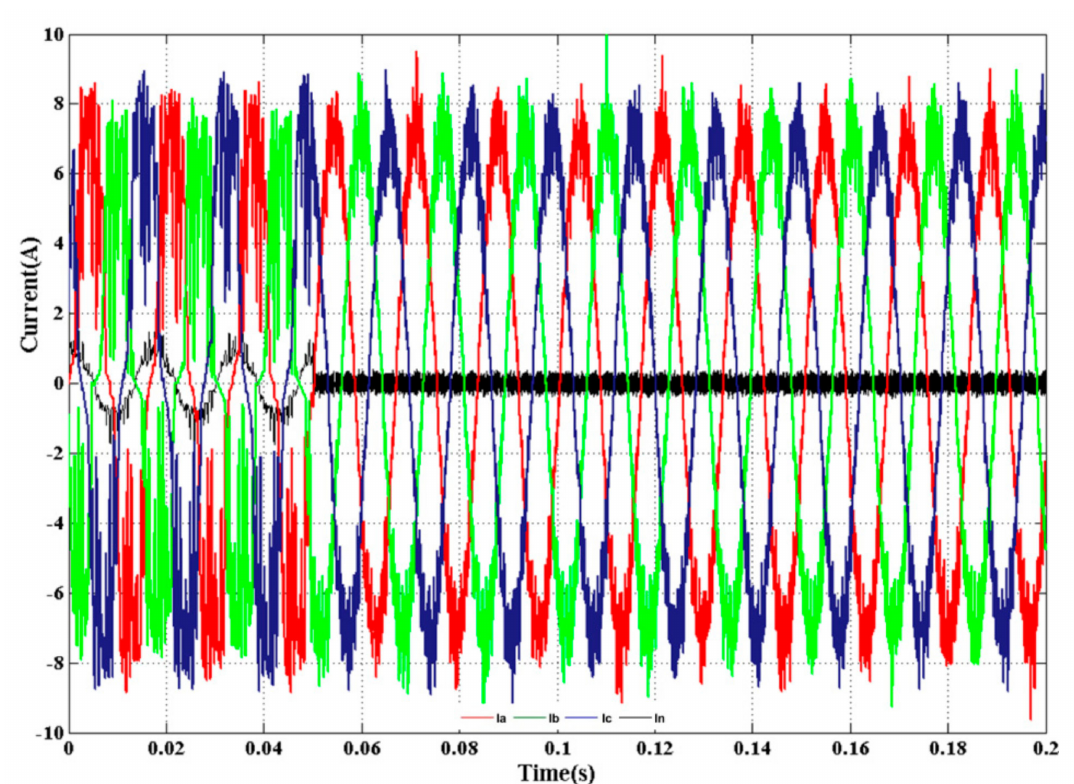
Figure 11. Experimental result of the traditional p-q method for case